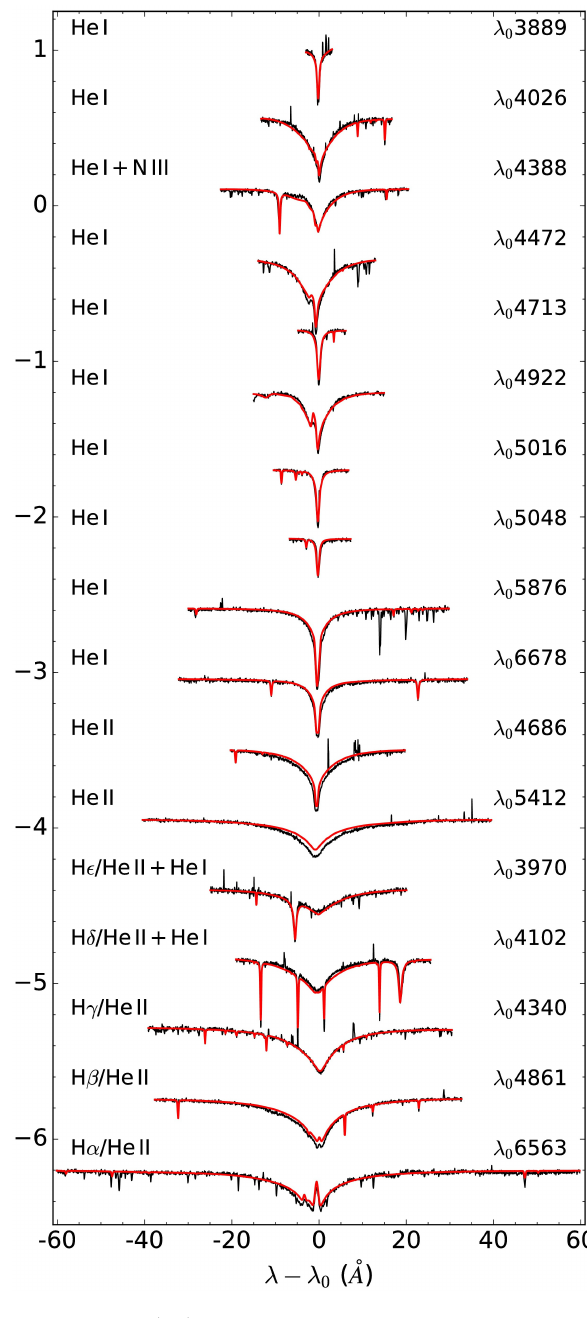
Figure 1. Best fit (red) to the optical Balmer and helium lines se- lected in the normalized FEROS spectra